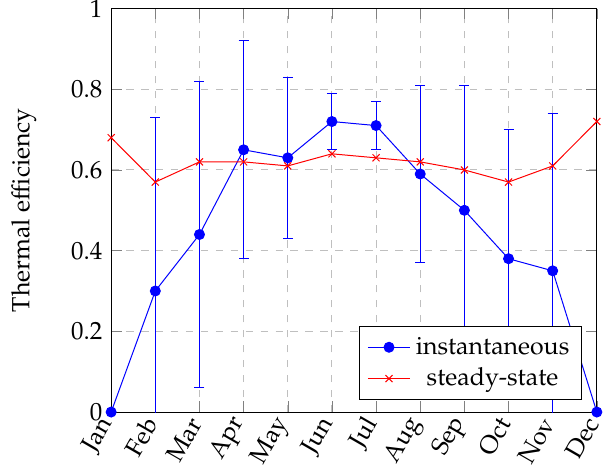
Figure 7. Average thermal efficiency for the controlled